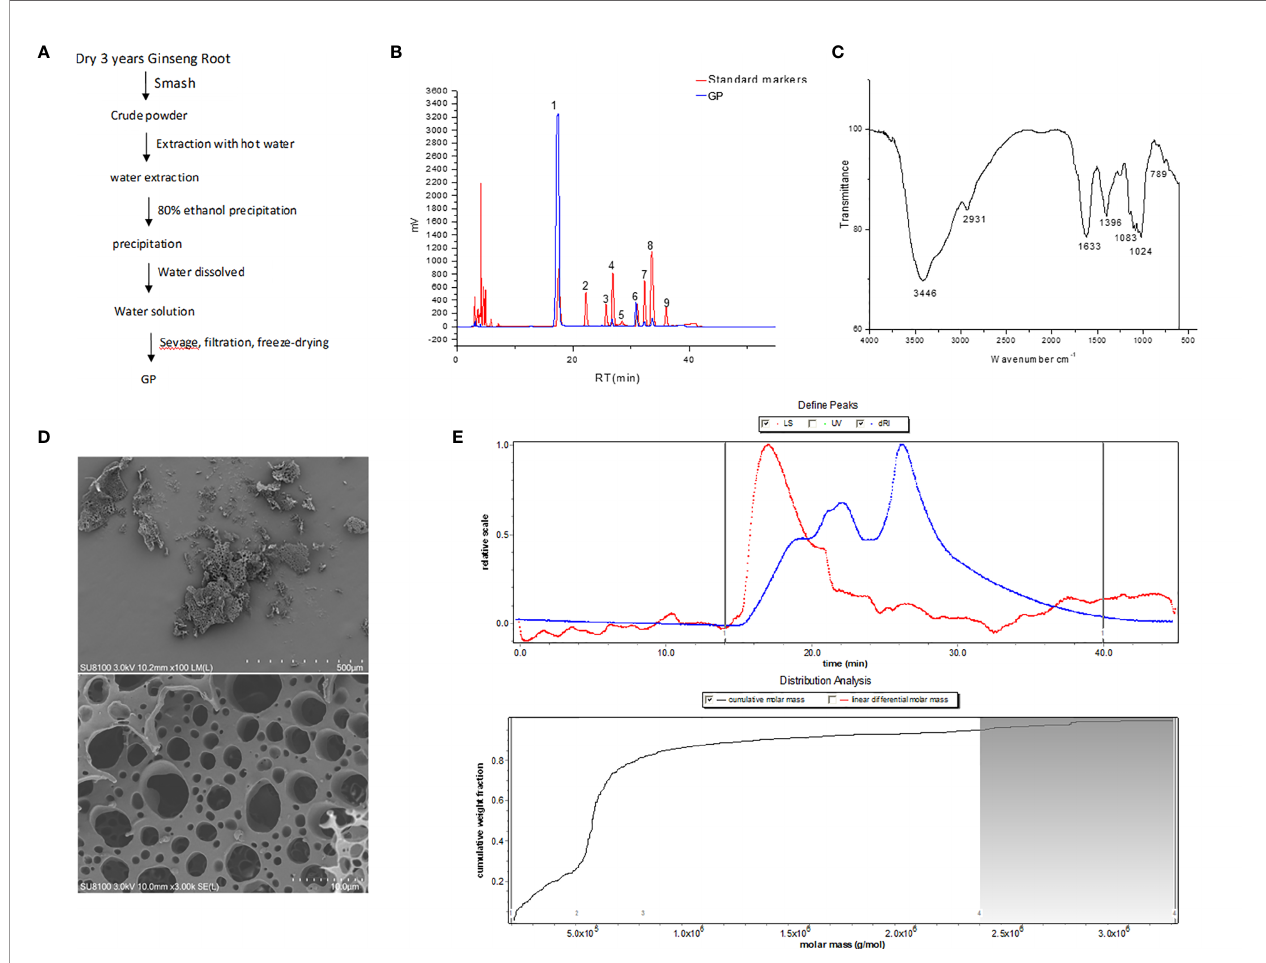
FIGURE 1 | Description and analysis of GP (A) Summarized extraction procedure. (B) HPLC of monosaccharide PMP derivatization. 1. PMP. 2. Mannose. 3. Rhamnose. 4. Glucuronic acid. 5. Galacturonic acid. 6. Glucose. 7. Galactose. 8. Arabinose. 9. Fucose. (C) Infrared spectroscopy. (D) Morphology by SEM. (E) Molecular weight